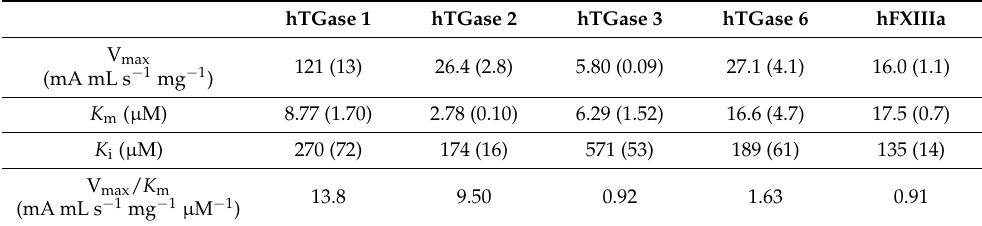
Table 1. Kinetic parameters of the substrate DMC for its TGase-catalyzed reaction with R-I-Cad